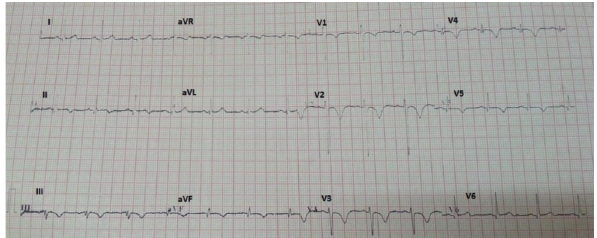
Figure 3: Electrocardiogram obtained 1 month after the acute coronary syndrome. It shows normalization of T wave in V6, I, and aVL. There is inversion of T wave and q wave in leads II, III, and